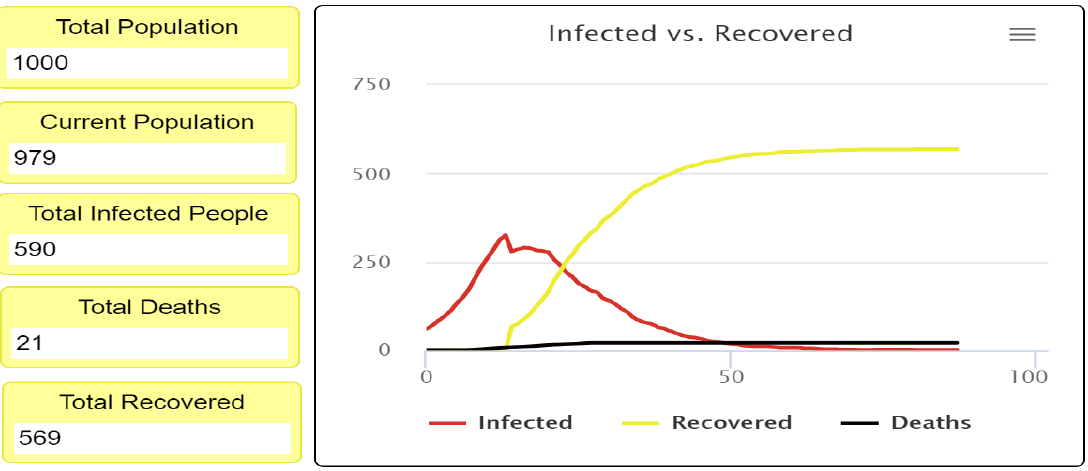
Figure 14. Infected versus the recovered people curve, when the fatality rate is 3% with 40% social distancing.